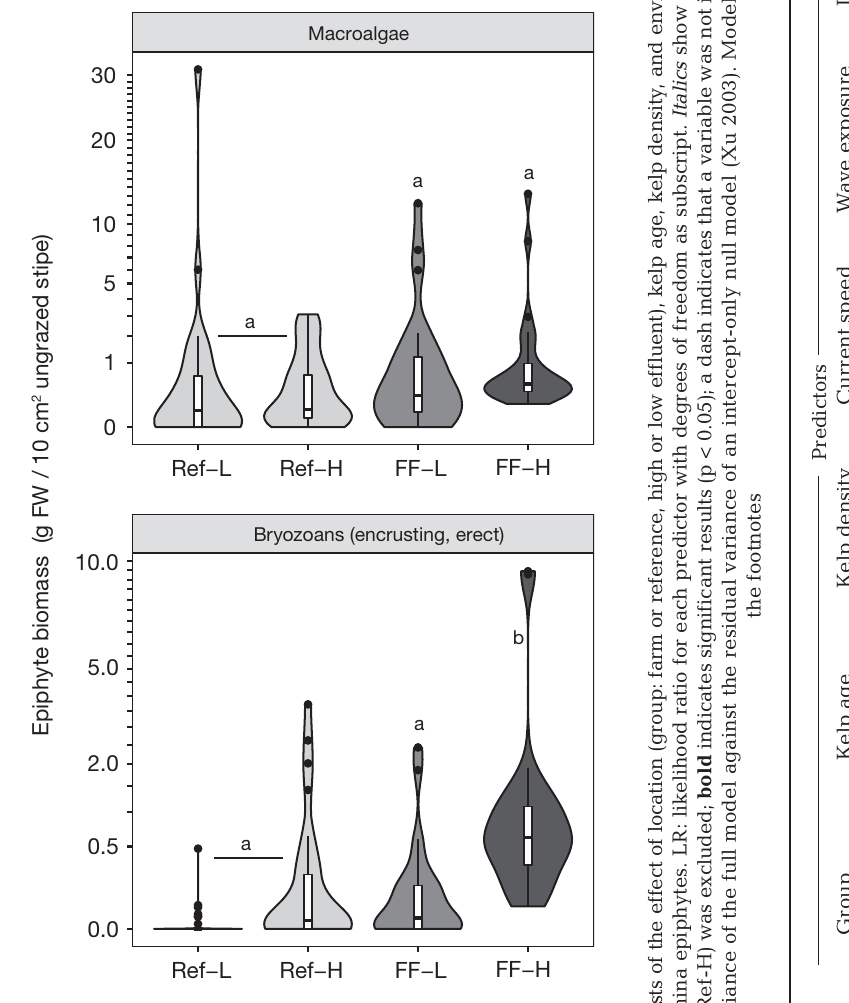
Fig. 5. Epiphytic biomass of macroalgae and bryozoans on stipes of Laminaria hyperborea kelp canopy plants collected at fish farm sites (low effluent levels: FF-L; high effluent lev- els: FF-H) and reference sites (Ref-L, Ref-H) in the Frøya (Ref-L, FF-L) and Smøla (Ref-H, FF-H) archipelagos, Nor- way. Each group consists of samples from 3 sites, each with 9−10 thalli. Note the use of different square-root scales on the y -axes. The distribution of the data within each group is shown by violin plots (scaled to have constant maximum widths); overlaid by boxplots showing the median, upper and lower quartiles (boxes), and the spread of the data within 1.5× the interquartile range (tails). Points represent observa- tions outside this range. Different letters denote significant difference (Dunnett’s post-hoc, α = 0.05)